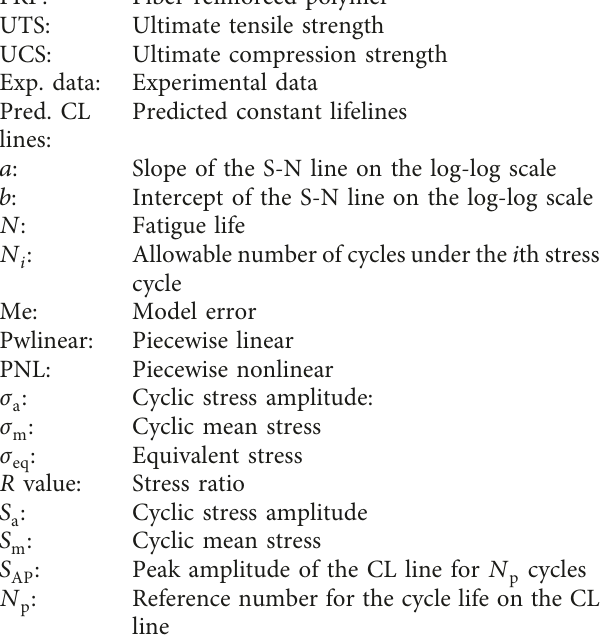
Table 4: Comparison of model prediction results for the 3/2 laminates under spectrum